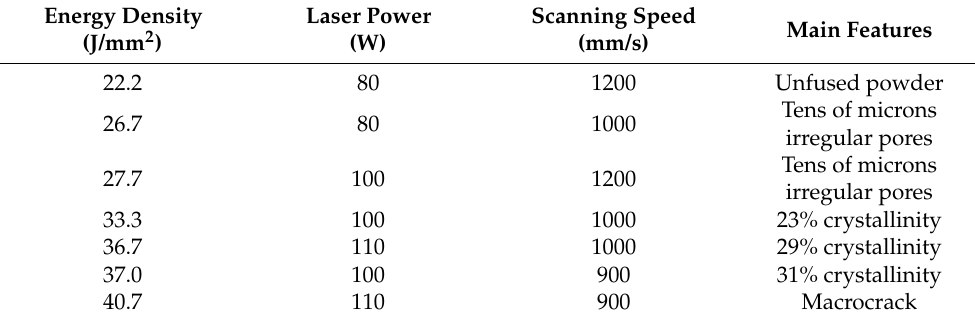
Table 1. Sample conditions with different processing